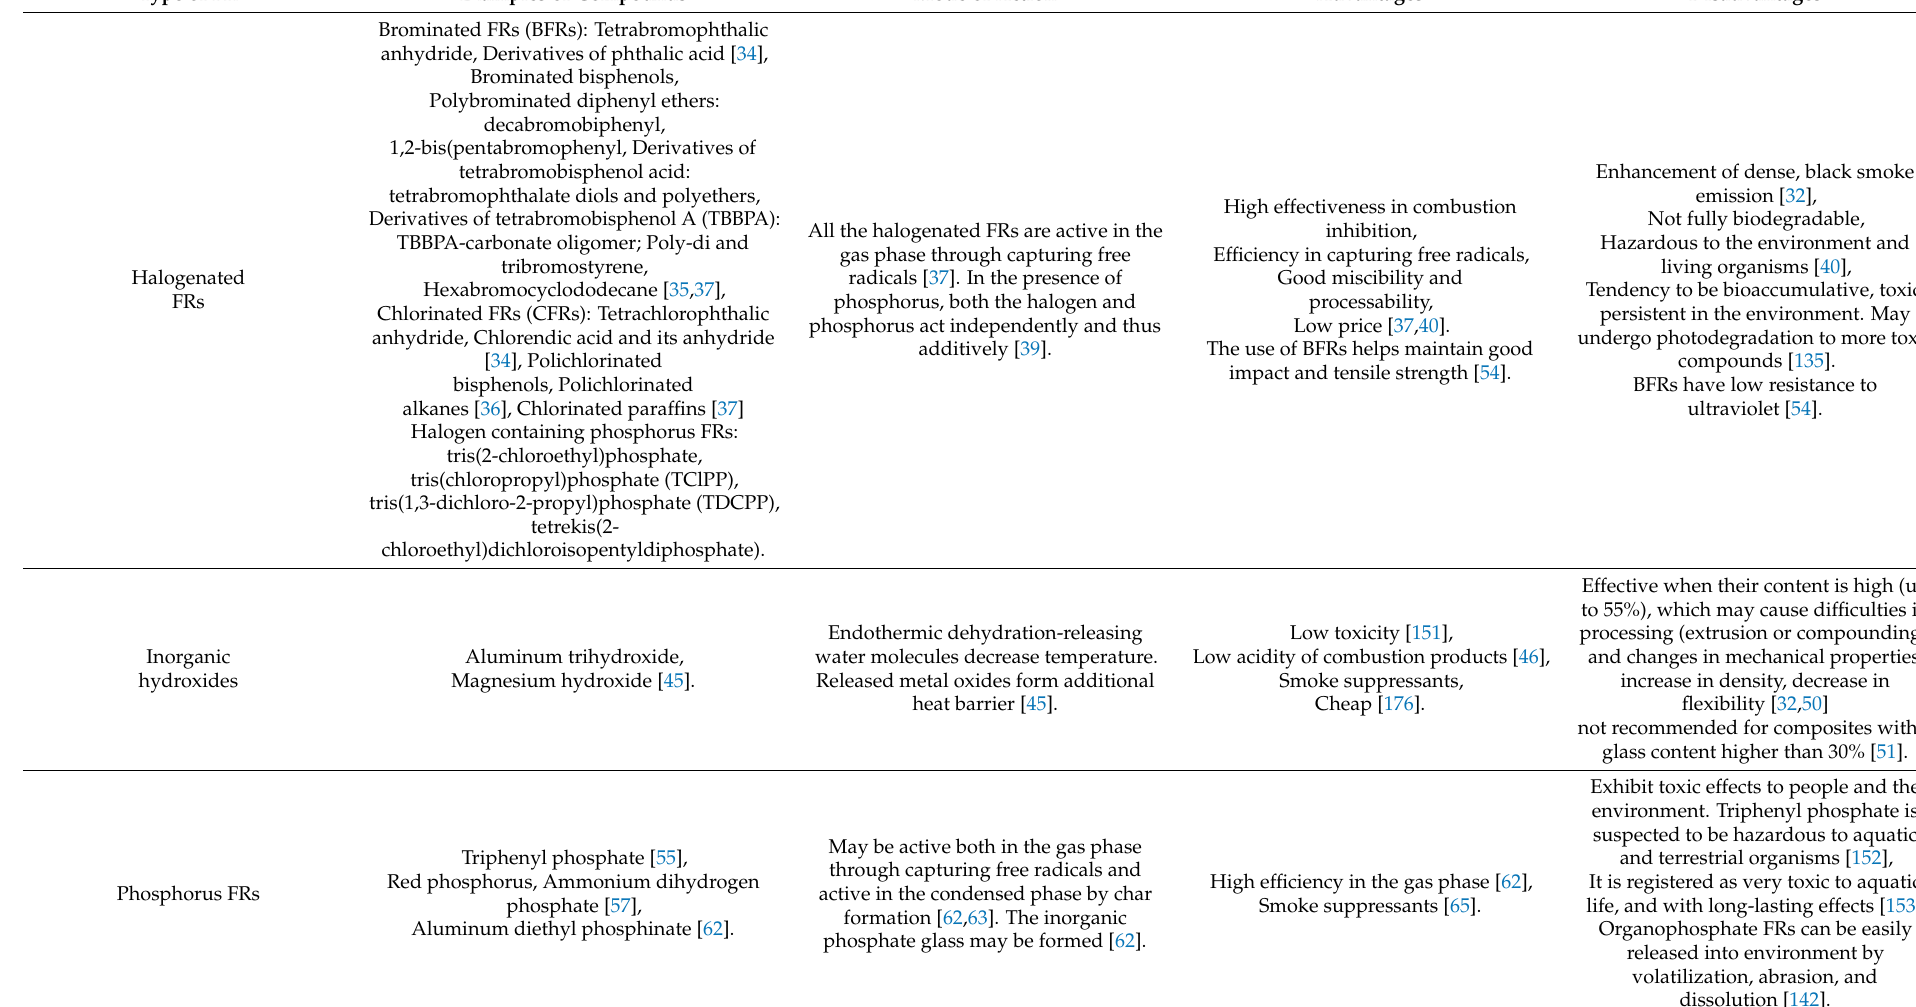
Table 3. A comparison of flame retardants (FR) for glass/polyester